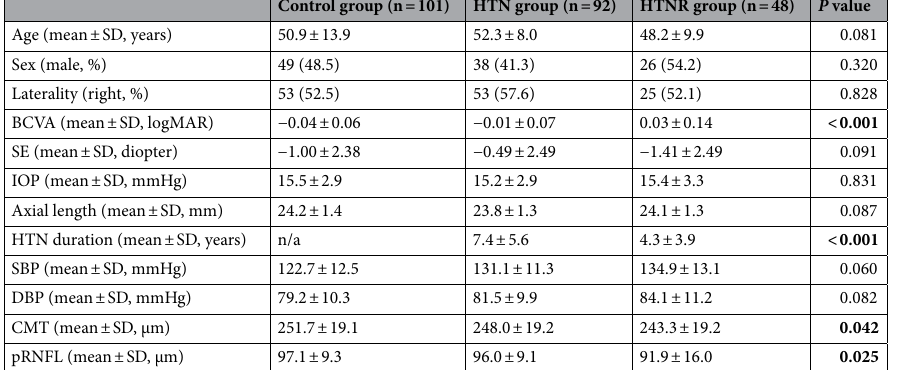
Table 1. Demographic and clinical characteristics. BCVA best-corrected visual acuity, SE spherical equivalent, IOP intraocular pressure, HTN hypertension, SBP systolic blood pressure, DBP diastolic blood pressure, CMT central macular thickness, pRNFL peripapillary retinal nerve fiber layer. Values in boldface ( P < 0.050) are statistically